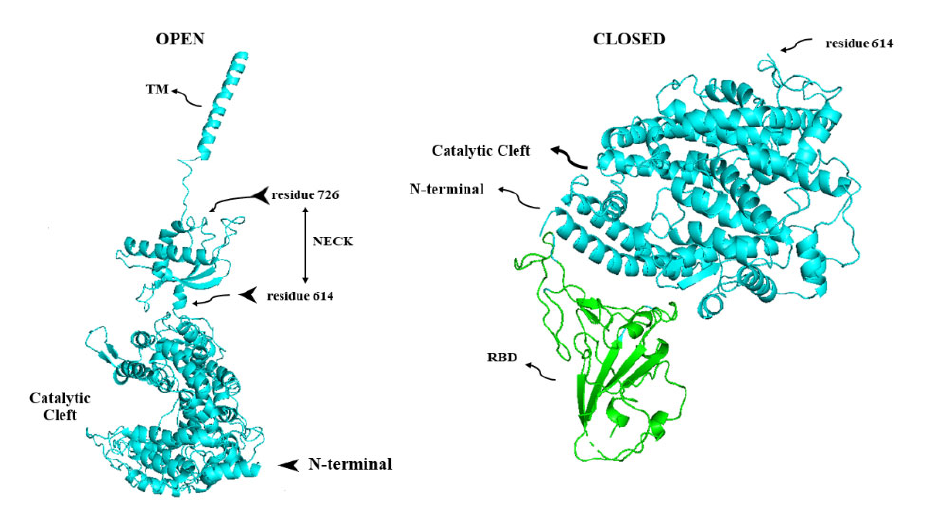
Figure 6. Three dimensional structure of open (catalytically active full length, greenish ‐ blue) (PDB ID: 6M1D, [247], PyMol molecular graphics system) and closed (catalytically inactive, greenish ‐ blue) (PDB ID: 7RPV, [248], PyMol molecular graphics system) forms of ACE2. As has been debated, com ‐ plexification of RBD (light green) and ACE2 protease domain (the “closed” figure) makes the cata ‐